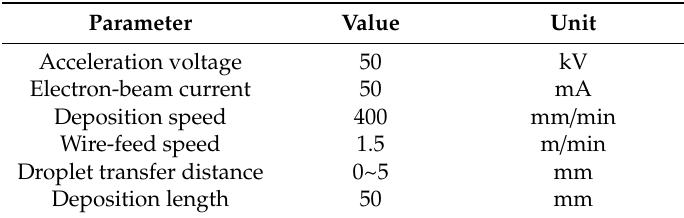
Table 1. Experimental parameters.